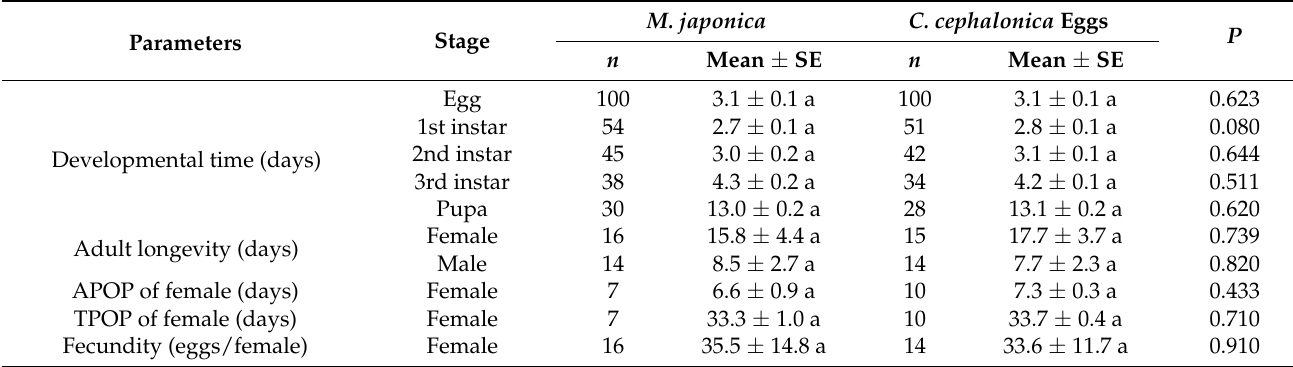
Table 1. Developmental time, longevity, and fecundity of Chrysopa pallens ever cultured on Megoura japonica and Corcyra cephalonica eggs fed on Aphis craccivora, under fluctuating temperature conditions in a greenhouse (paired bootstrap test, B = 100,000, the same lowercase letters in the same column indicate the values are not significantly different, P > 0.05). M. Parameters Stage